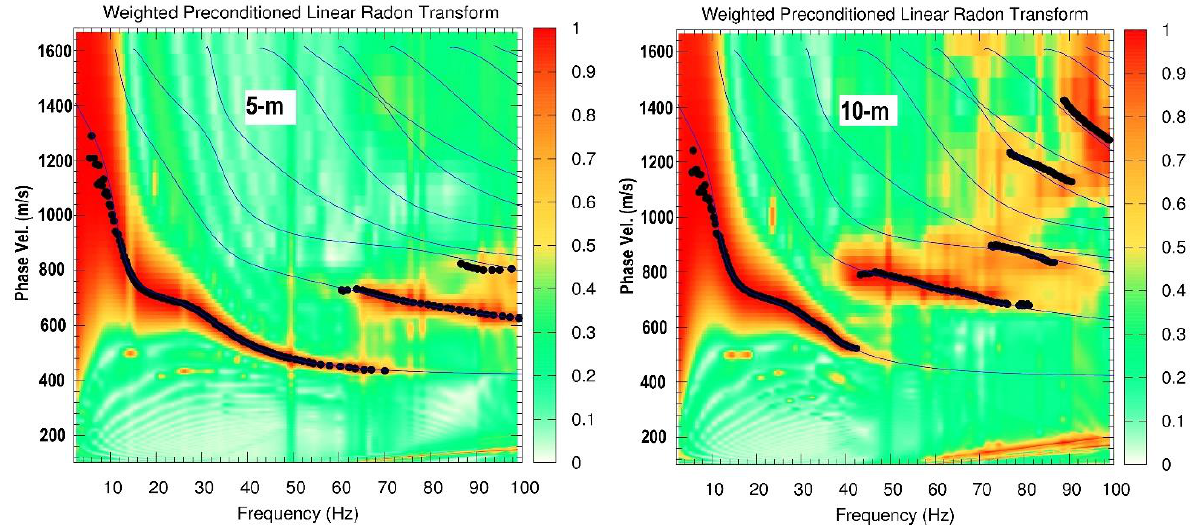
Figure 14. Multi-mode phase velocities for the model structure in Table 2 computed by setting the source depth to 5-m (left panel) and 10-m (right panel). Both phase velocity dispersion images are obtained from the method of linear radon transform weighted and preconditioned. The solid circles show the fundamental mode plus higher mode phase velocities changing with